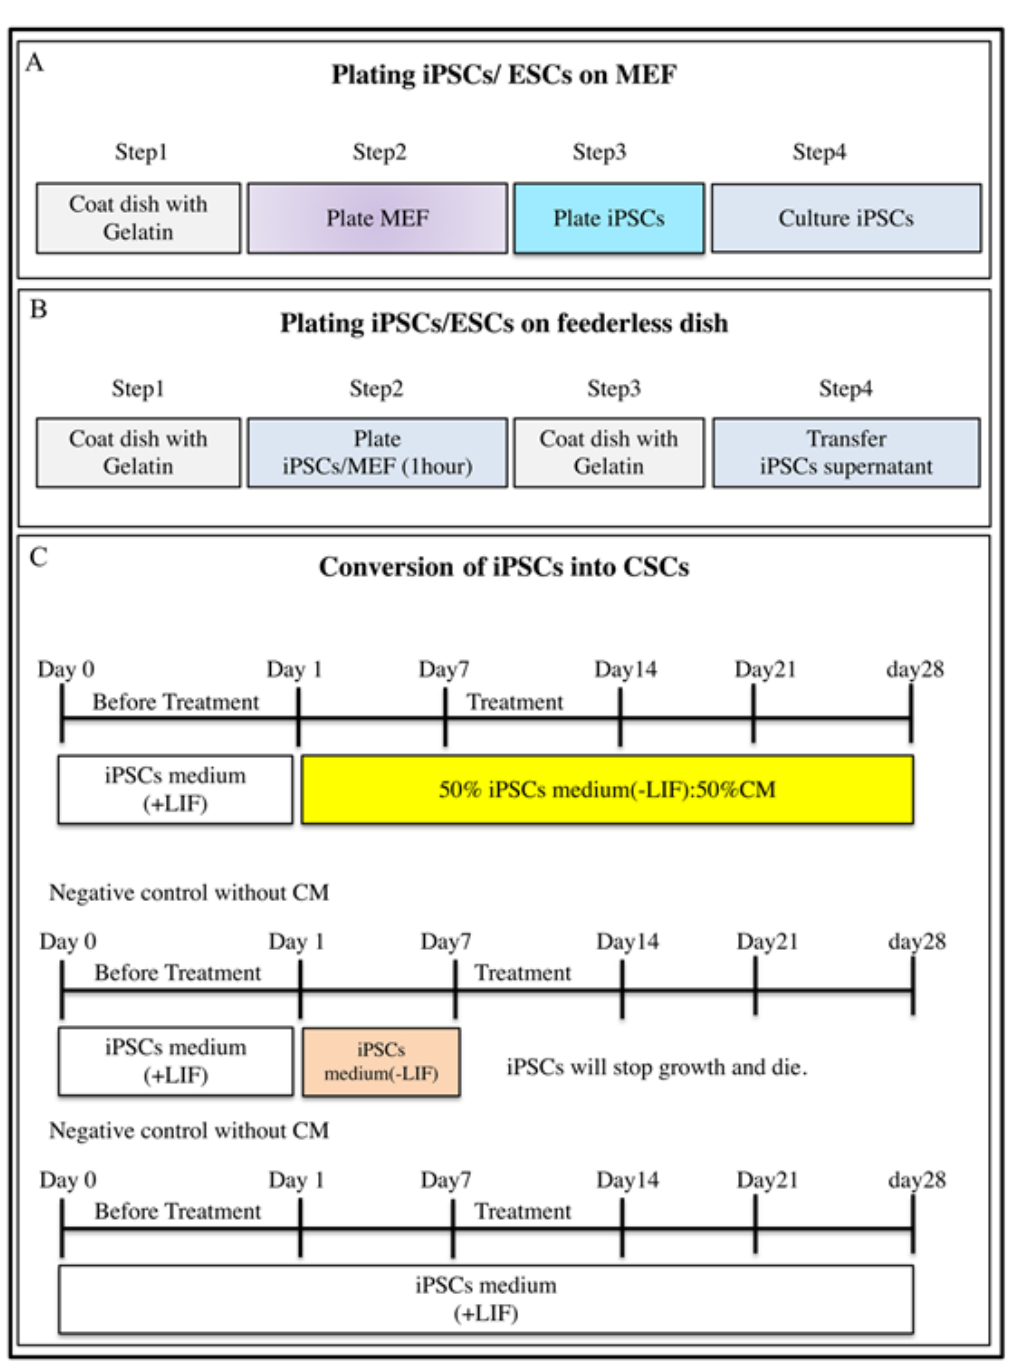
Figure 1. Representative scheme for conversion of stem cells into cancer stem cells. ( A ) Steps for plating induced pluripotent stem cells (iPSCs) / embryonic stem cells (ESCs) on mitomycin C-treated mouse embryonic fibroblast (MEF) feeder cells. ( B ) Steps for plating induced pluripotent stem cells (iPSCs) / embryonic stem cells (ESCs) on feederless gelatin-coated dishes. ( C ) Representative scheme for conversion of induced pluripotent stem cells (iPSCs) / embryonic stem cells (ESCs) into cancer stem cells (CSCs) in the presence of conditioned medium (CM) from cancer cell lines, and negative control without